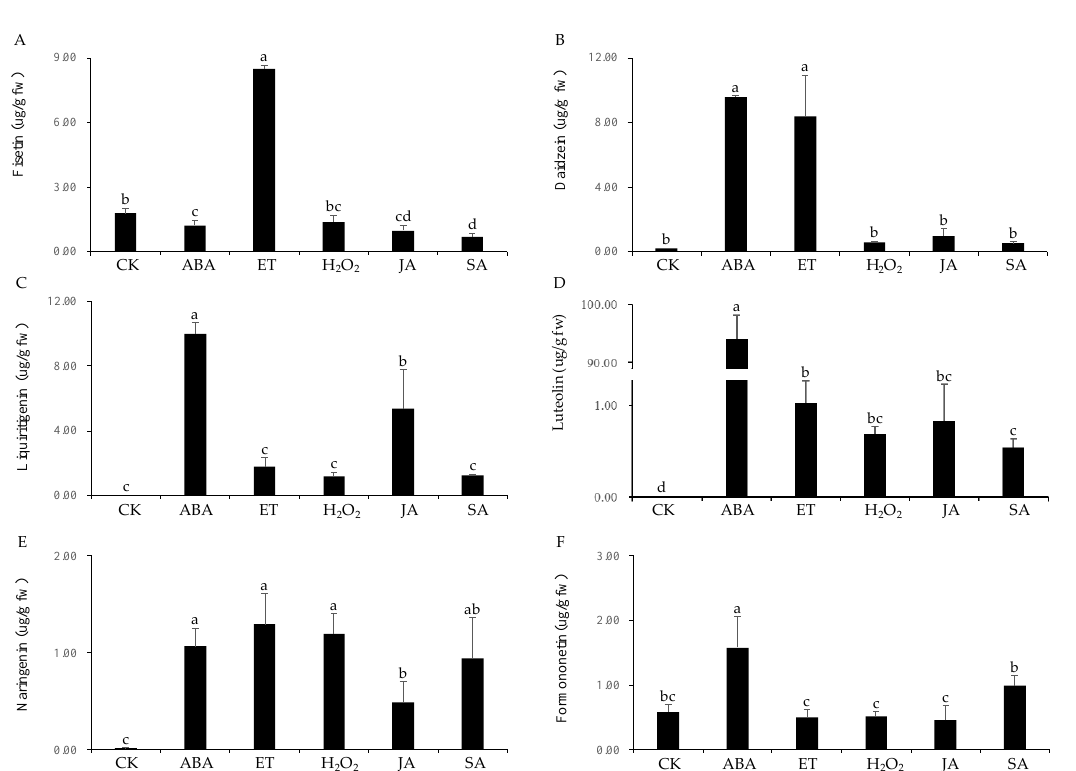
Figure 8. Induction patterns of six flavonoids in response to the treatment of cell suspension cultures with ABA, ET, H 2 O 2 , JA, and SA.